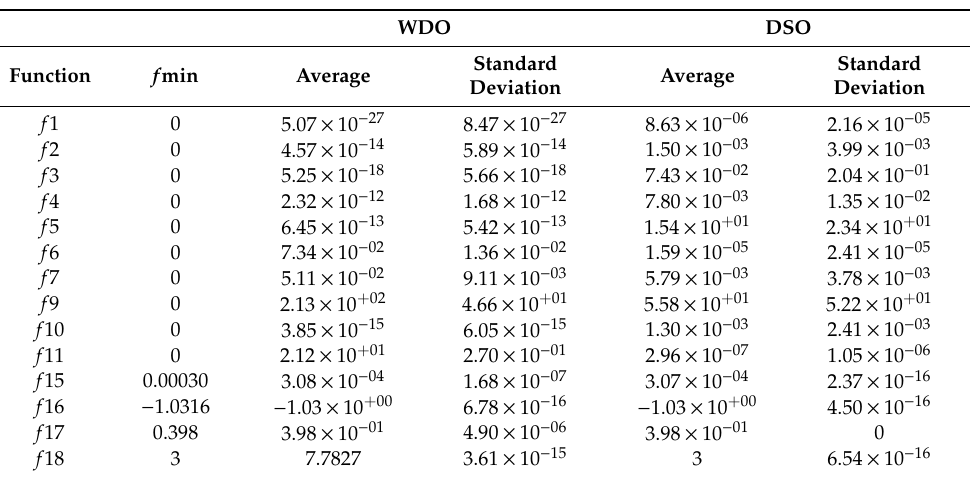
Table 9. Simulations results for 64 dimensions.